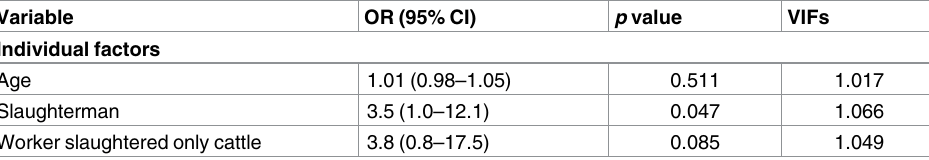
Table 4. Results of multi-level analysis for risk factors for RVFV seropositivity in slaughterhouse